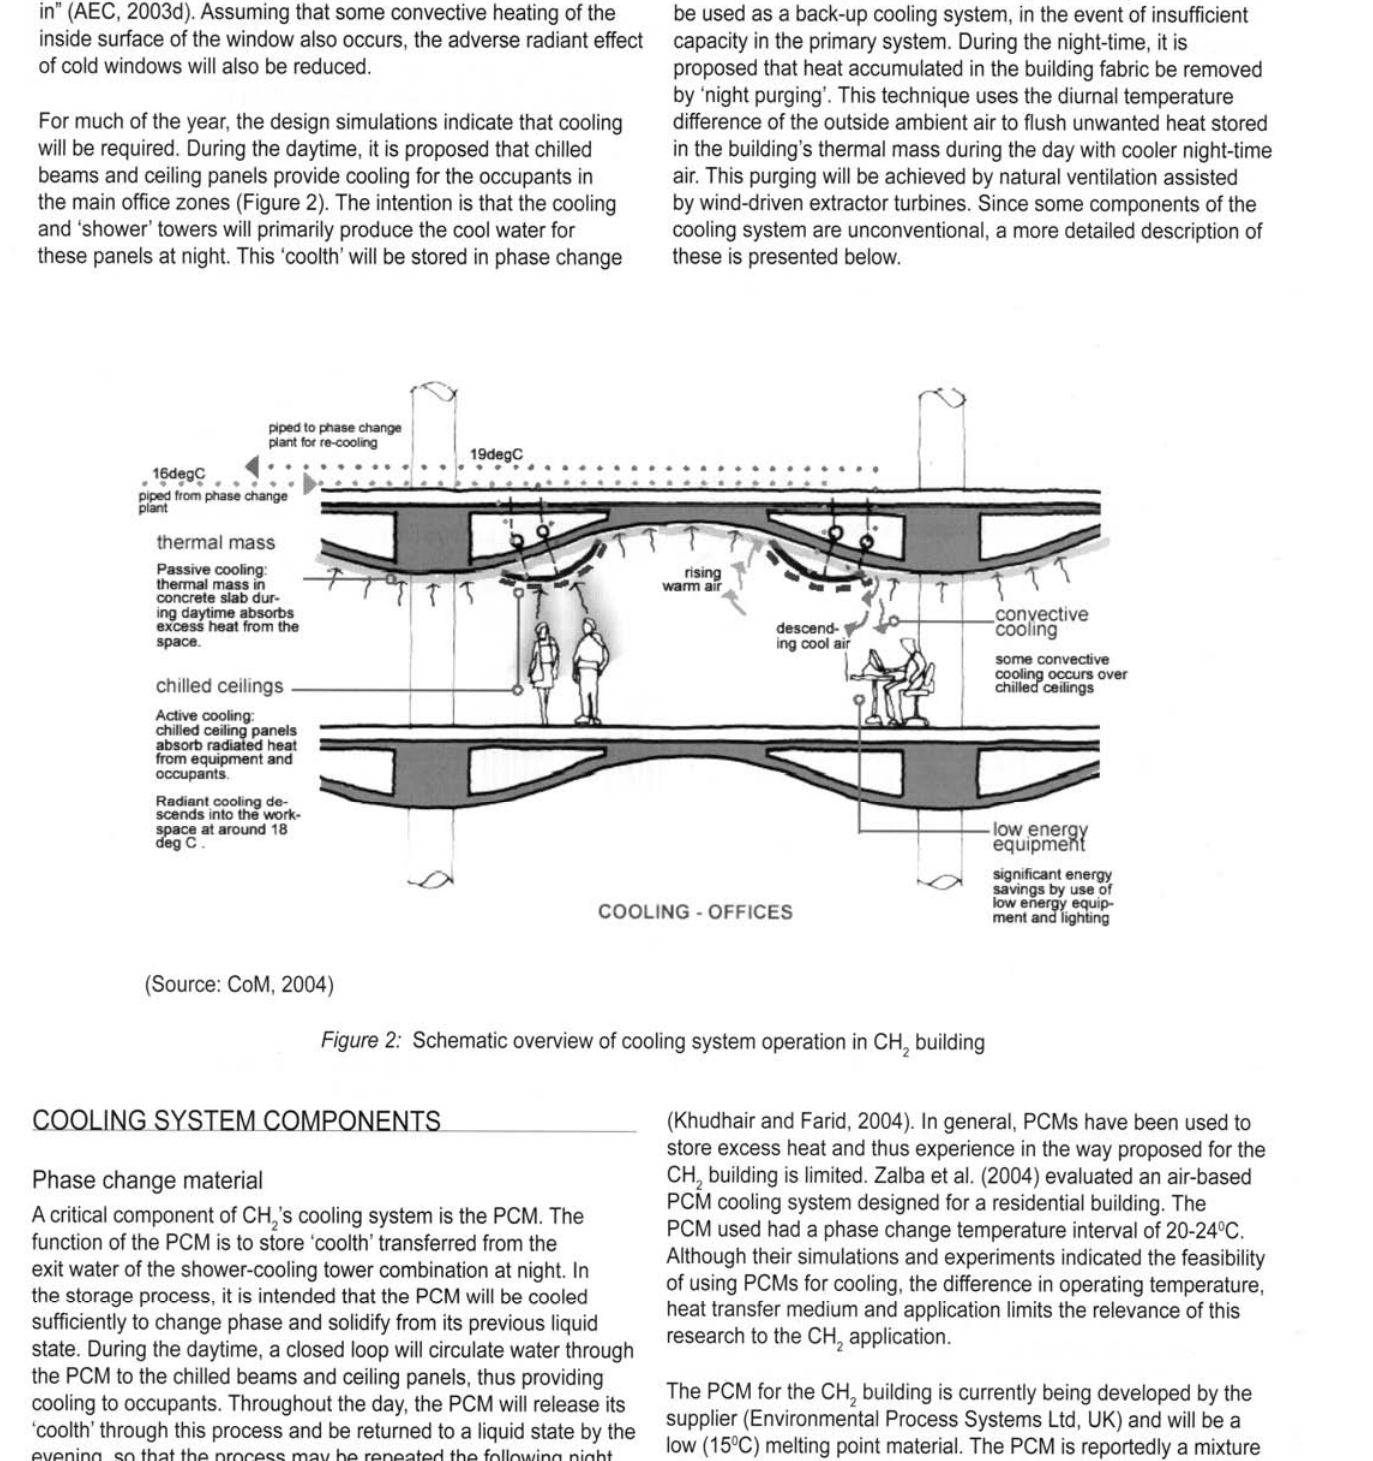
Figure 2: Schematic overview of cooling system operation in CH